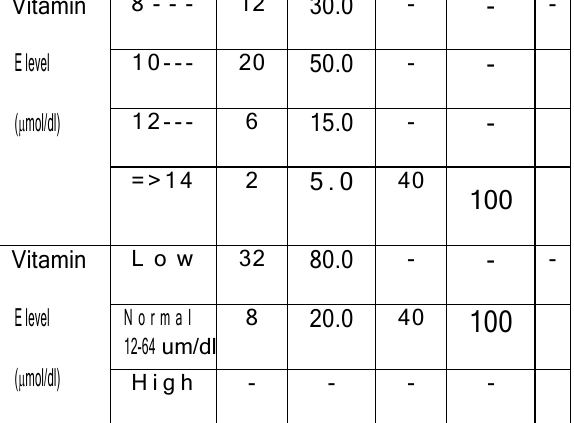
This table(3-3) shows that vitamin e level in (30% ) of (FRDA) patients was (8-9.9µg/ml), (50%) were with (10- 11.9 µg/ml), (15 %) were of (12-13.9 µg/ml ), and (5%) were with vitamin E level of equal or more than 14 µg/ml. These finding revealed that majority of Friedreich ataxia patients were found with low vitamin E (32 patients; 80%), and low percentage with normal level (8 patients; 20%).